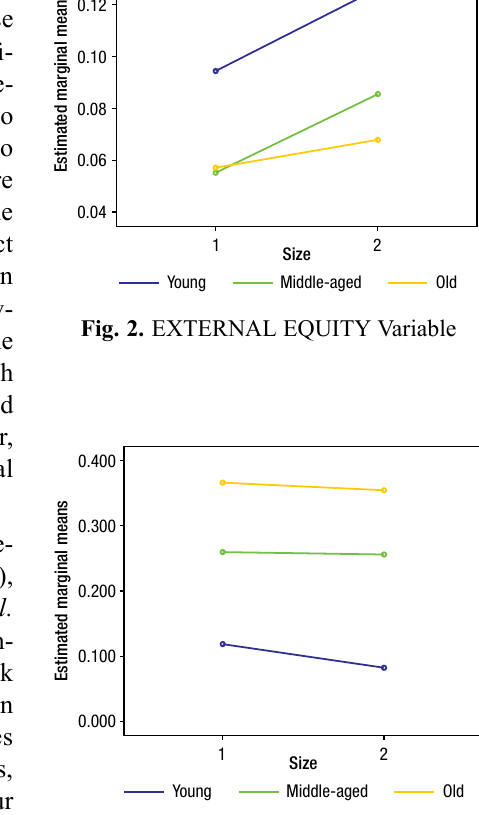
Fig. 3. RETAINED EARNINGS